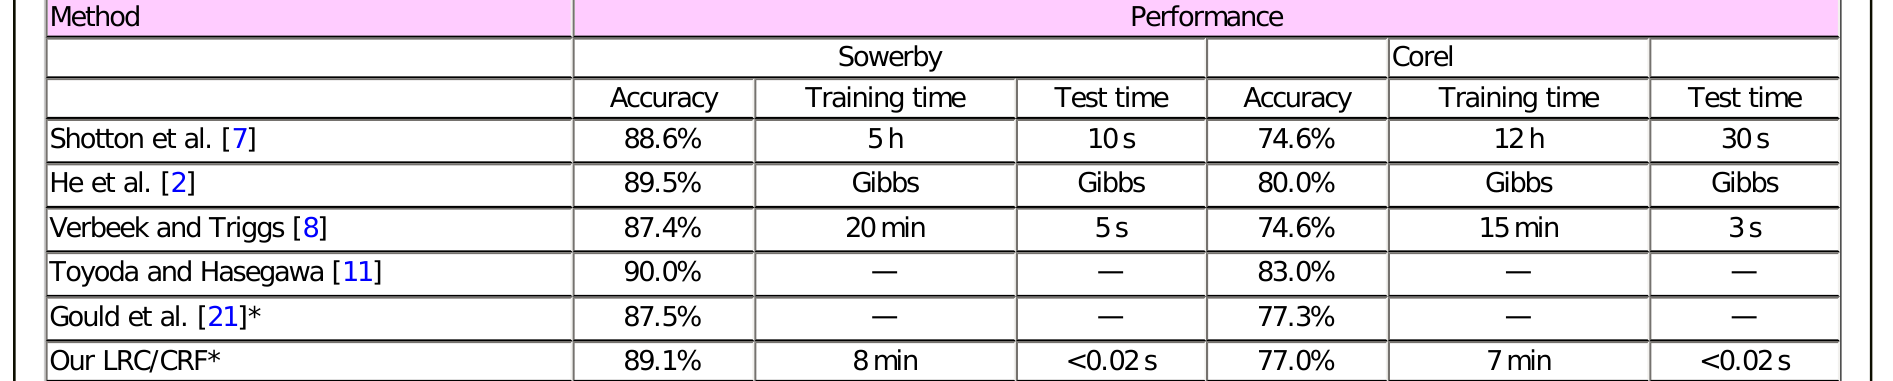
Table 5 Pixel level labeling accuracies for various algorithms on Sowerby and Corel.